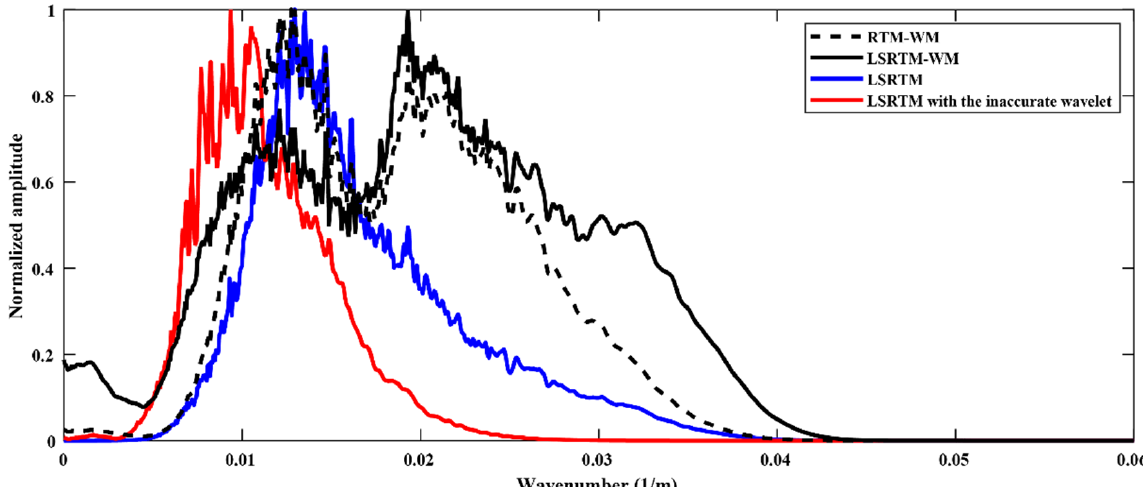
Figure 13. Wavenumber spectra comparison in the depth direction for different migration images. The dashed black, solid black, solid blue, and solid red lines represent the wavenumber spectra for images from RTM-WM (Figure 10a), LSRTM-WM (Figure 10b), LSRTM (Figure 9a), and LSRTM with the inaccurate wavelet (Figure 11), respectively.